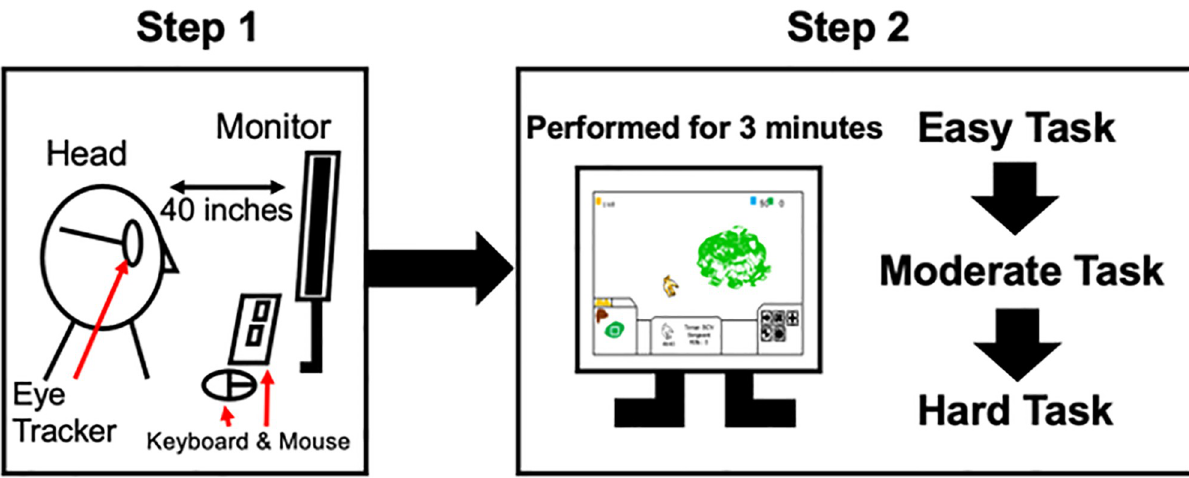
Fig 1. Overall flow of the task. These steps show the overall flow of the